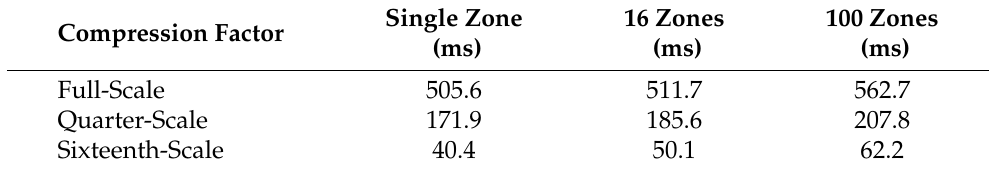
Table A3. Source-identification run-time.